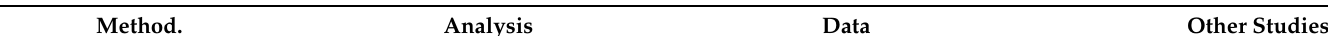
Table 1. Summary of methods and data used in this study and in other referenced